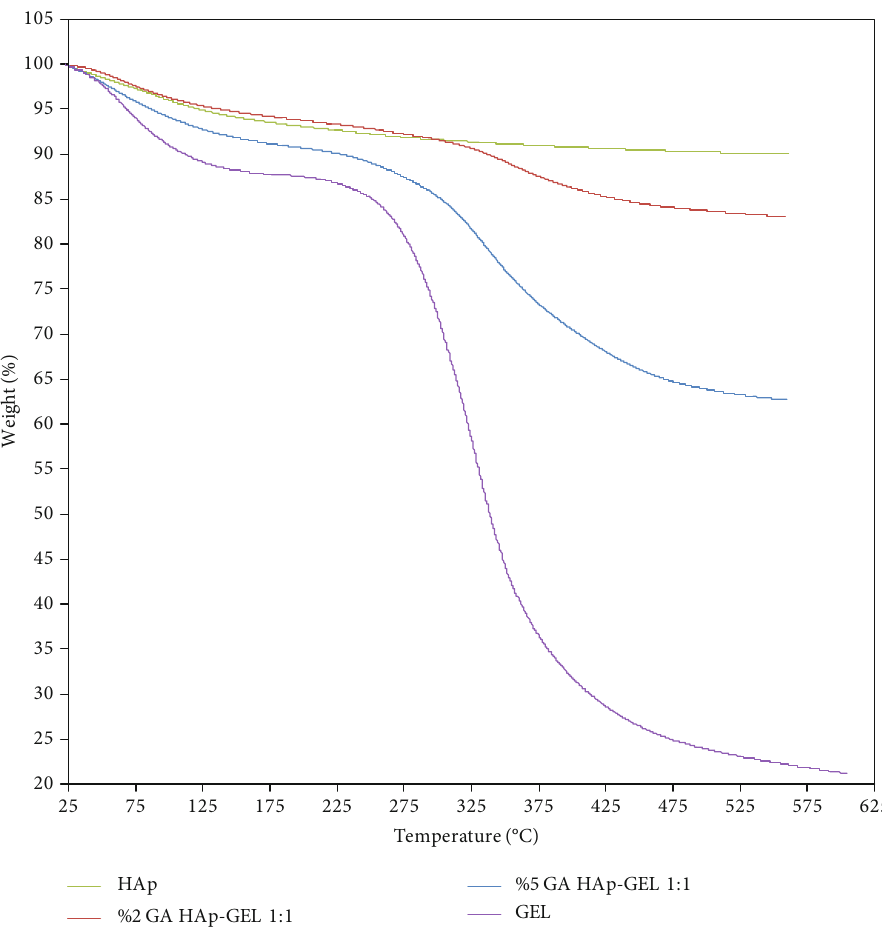
Figure 3: TGA patterns of pure HAp, pure gelatin, and the HAp-GEL composites cross-linked with di ff erent amounts of